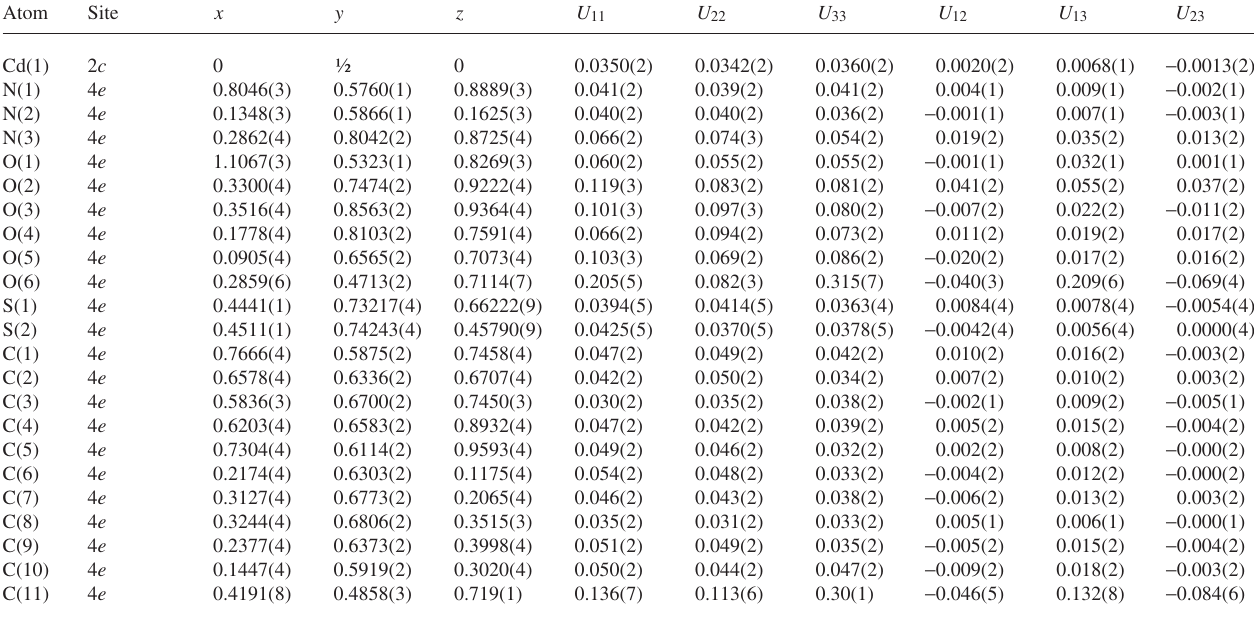
Table 3. Atomic coordinates and displacement parameters (in Å 2 )